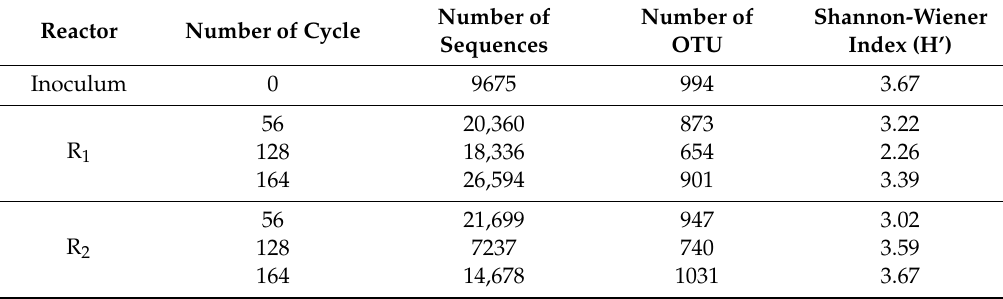
Table A2. Diversity indices from aerobic granular sludge sample in